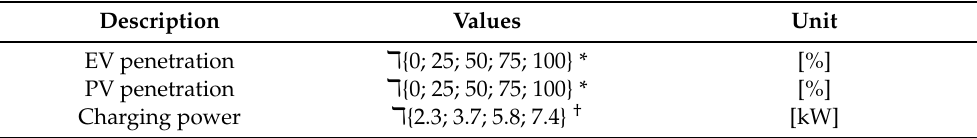
Table 3. Overview of the simulation